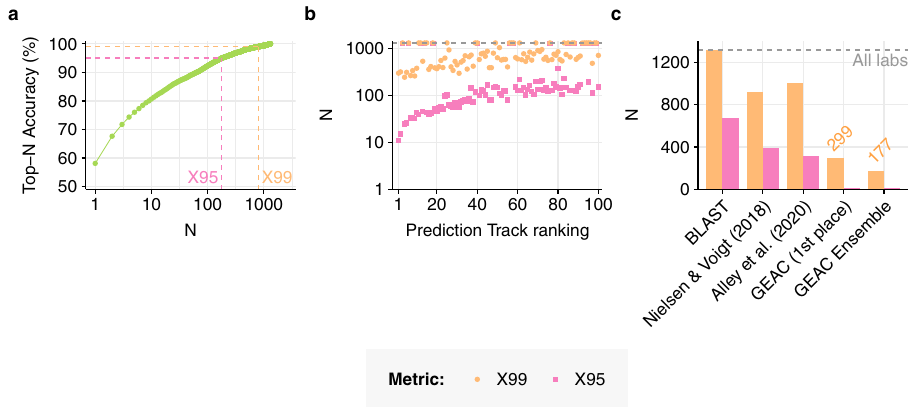
Fig. 3 | Rank metrics for ef fi cient genetic forensics. a For any given lab-of-origin predictor, the X99 score is the smallest positive integer N such that the top-N accuracyofthepredictorisatleast99%.Analogousmetricscanbede fi nedforother thresholds; for example, the X95 score is the smallest N such that top-N accuracy exceeds95%. b X99&X95scoresachieved byeach of thetop 100PredictionTrack teams, on a logarithmic scale. c X99 & X95 scores achieved by past ML-based